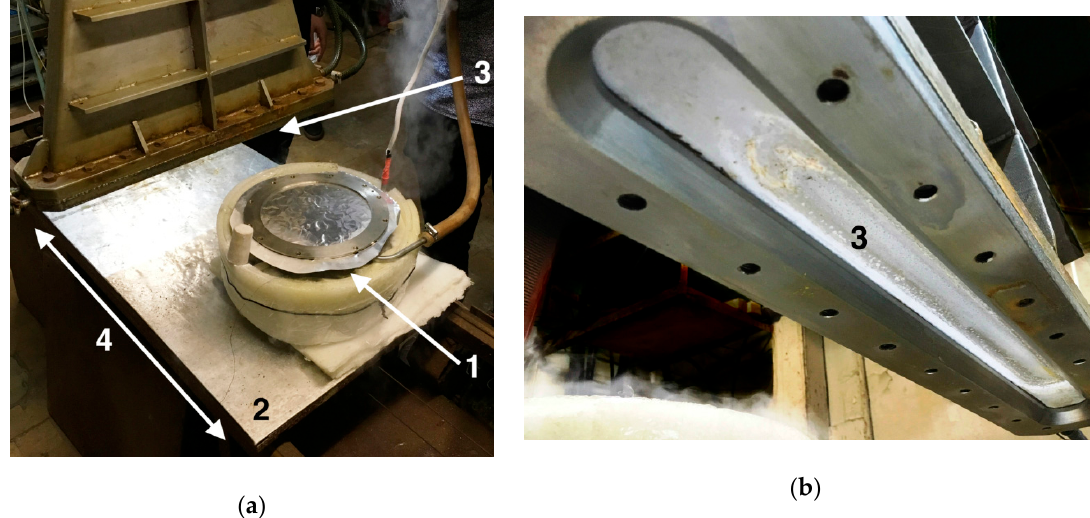
Figure 2. Climatic chamber and exit window of accelerator: ( a ) chamber on mobile platform under the exit window of accelerator; ( b ) exit window of accelerator. 1—chamber, 2—mobile platform, 3—exit window of accelerator, 4—direction of movement of the platform.